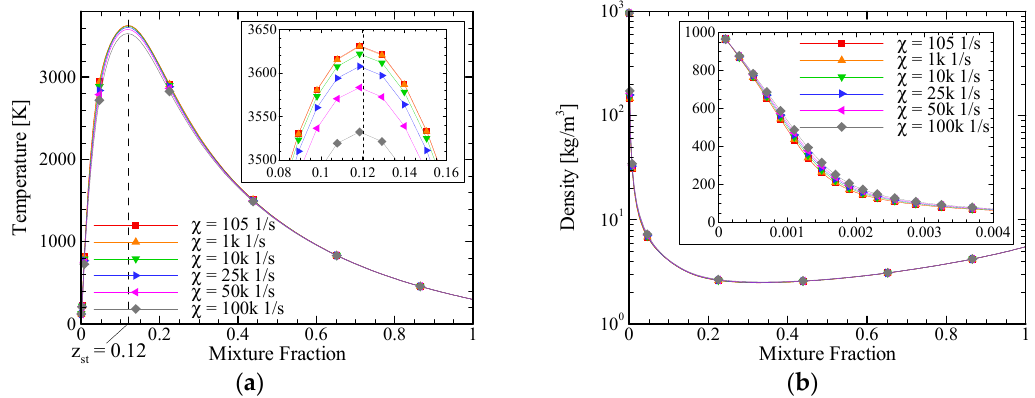
Figure 7. Graphs from generated flamelet table: ( a ) mixture fraction verses temperature; ( b ) mixture fraction verses density. In graph ( a ), mixture fraction range for small frame is reset to 0.08–0.16. In graph ( b ), mixture fraction range for small frame for is reset to 0–0.004, and solely ordinate axis for larger frame is expressed in log scale.